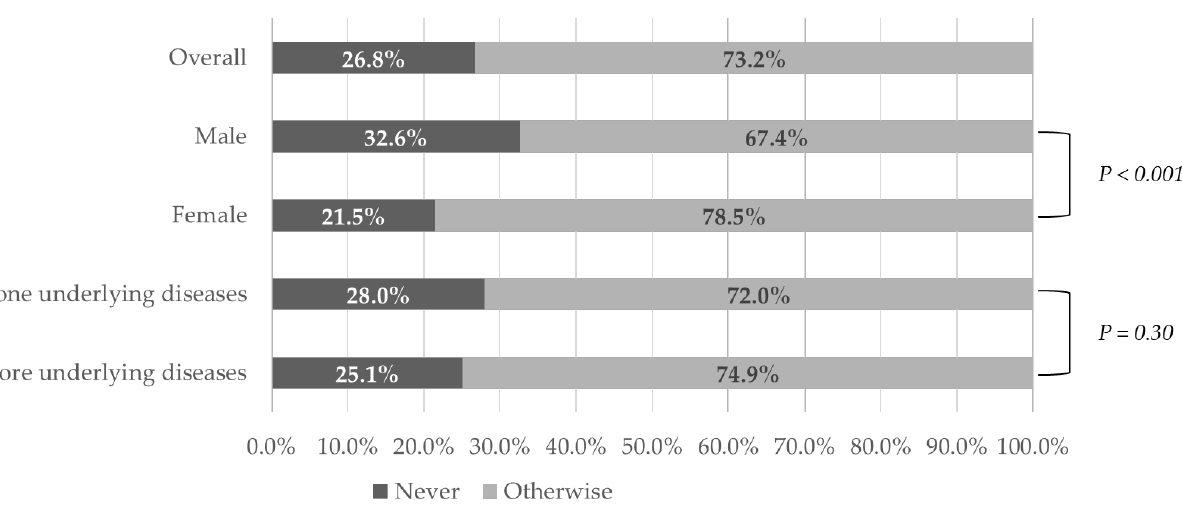
Figure 1. Healthcare utilization avoidance among subgroup participants based on gender and the presence of an underlying disease.